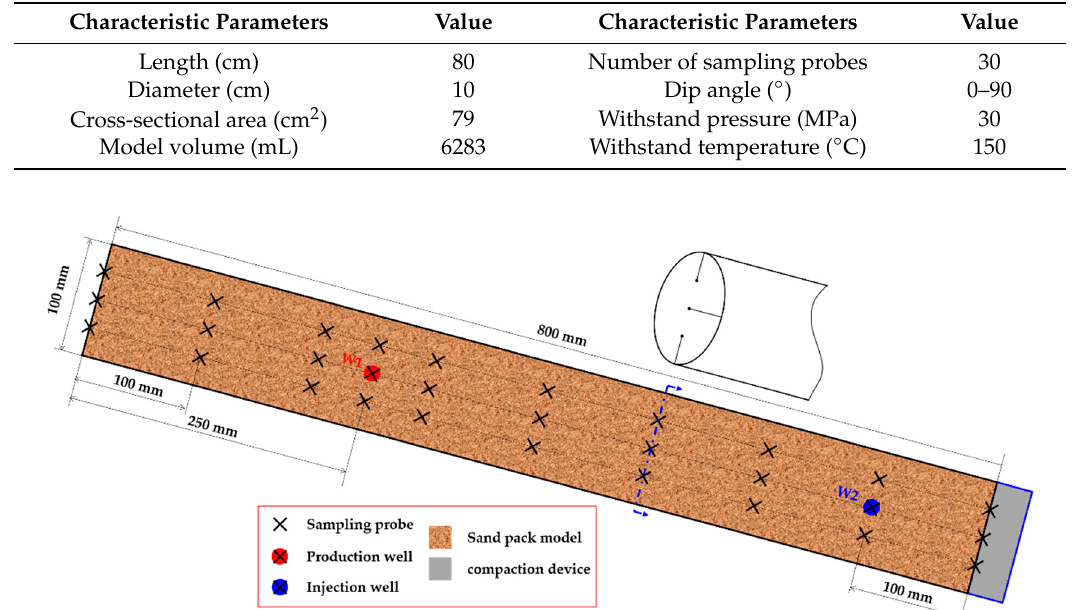
Figure 1. The distribution of sampling probes in the longitudinal section. Table 1. Basic characteristic parameters of the experimental model.